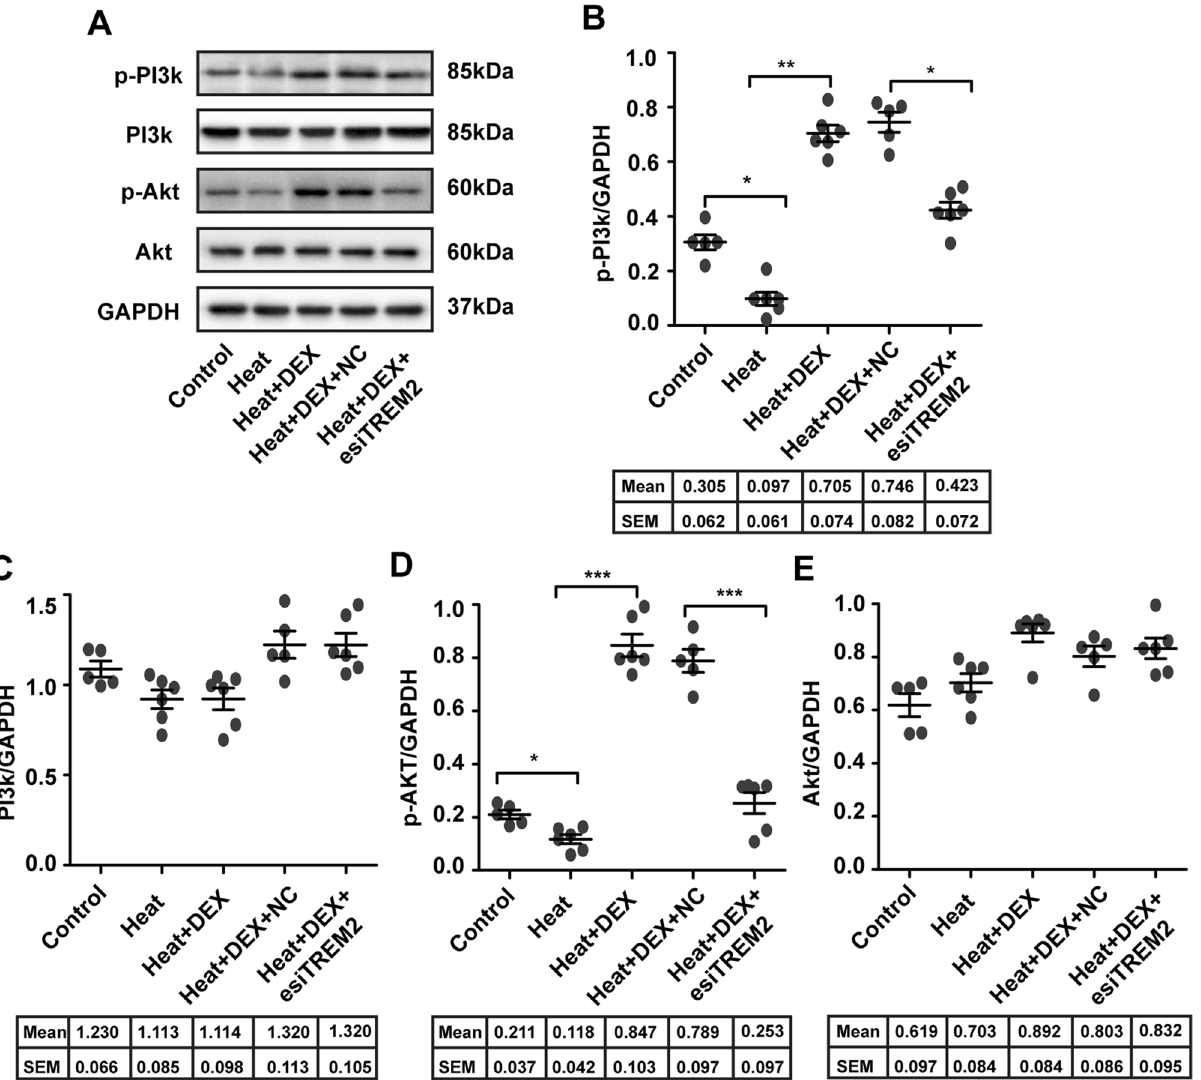
Figure 6. Involvement of TREM2 in the regulation of the PI3K/AKT signalling pathway in heat exposure- treated BV-2 cells. BV-2 cells were pretreated with or without DEX (16 µg/ml) and TREM2 esiRNA (50 nM), and then subjected to a heat exposure at 42 °C for 2 h, followed by a 6-h recovery period at 37 °C. ( A ) The phosphorylation and total protein levels of PI3K and Akt in the cytosol were analysed using Western blotting. Original Western blots are presented in the Supplementary Figure. ( B – E ) Densitometric analysis was performed for PI3K, p-PI3K, Akt and p-Akt. The data are shown as the mean ± SEM of three independent experiments. Statistical analysis: two-way